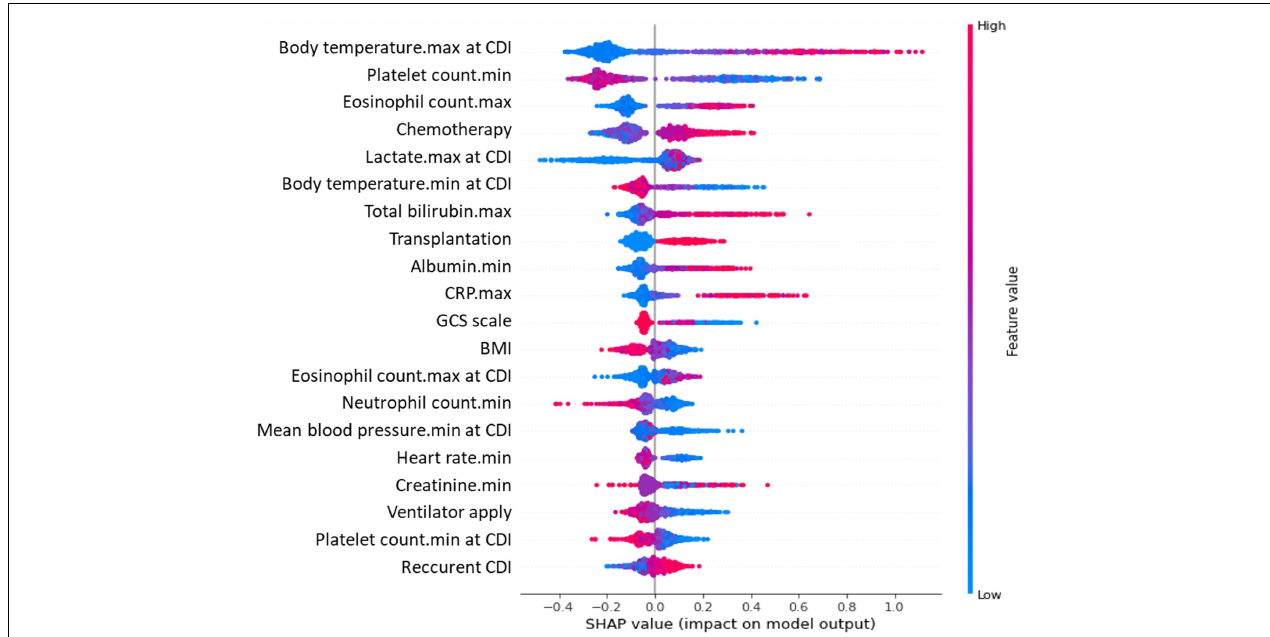
FIGURE 2 | Critical variables with SHAP values for predicting severe CDI. SHAP, Shapley additive explanation; CDI, Clostridioides difficile infection; SOFA, sequential organ failure assessment; CRP, C-reactive protein; GCS, Glasgow Coma Scale; BMI, body mass index. A SHAP value summary dot plot of the light gradient boosting model. The color of the SHAP dot represents the value of the feature, and the location of the dot on the X-axis represents the SHAP value. Red dots indicate higher values or affirmative responses, and blue dots indicate the opposite. A positive SHAP value indicates that the variables increase the likelihood of severe